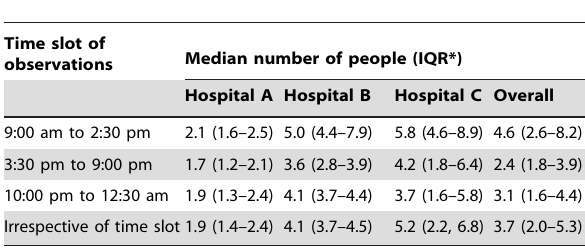
Table 2. Median number of people present per 10 m 2 in three hospitals, 2007.